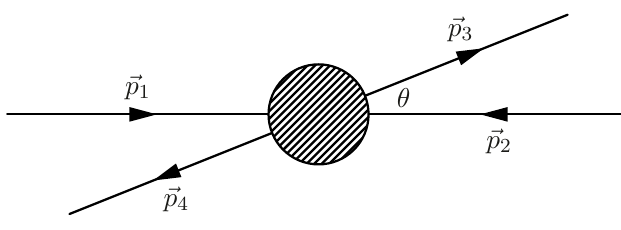
Figure 1 . 2 2 scattering configuration in the center-of-mass frame, with incoming massless → particles carrying momenta p 1 and p 2 , and outgoing particles momenta p 3 and p 4